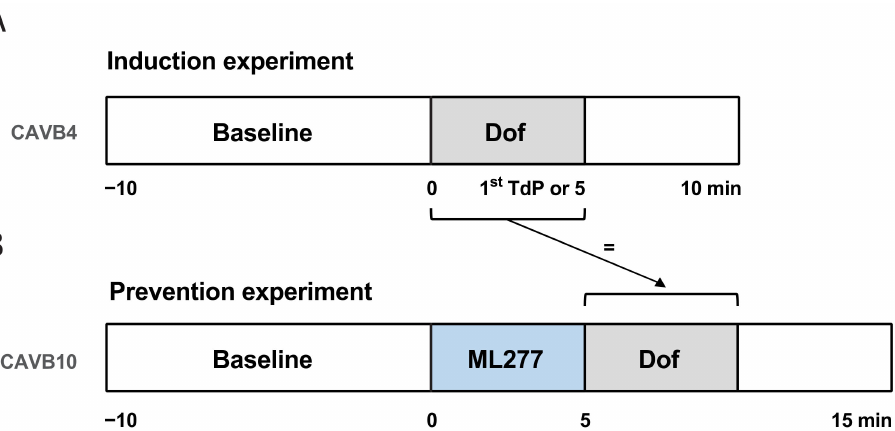
Figure 1. Schematic overview of the experimental setup. Two experiments were performed in series. ( A ) Induction experiment at chronic AV block 4 ± 2 weeks (CAVB4): baseline measurement followed by dofetilide (Dof) infusion until first Torsade de Pointes (TdP) arrhythmia or maximum infusion of 5 min. ( B ) Prevention experiment at CAVB 10 ± 2 weeks (CAVB10): baseline measurement followed by 5 min of ML277 and Dof infusion with identical duration as during the induction experiment. Recordings were followed up for 10 min after the start of Dof